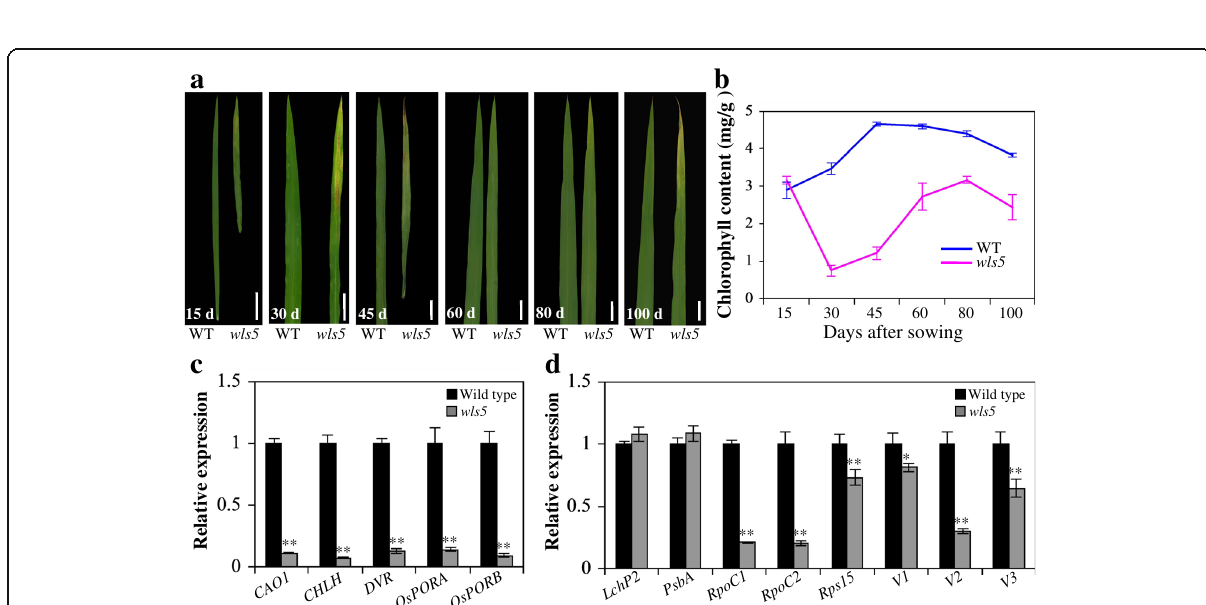
Fig. 4 Comparison of leaf senescence over time between wild-type (WT) and wls5 plants. a Leaf phenotype of WT ( ‘ 93 – 11 ’ ) and wls5 plants at different stages (The youngest fully expanded leaf). Bars = 2 cm. b Chlorophyll content of leaves in wild-type and wls5 plants. Error bars indicate SD, n = 10. c , d Expression of chlorophyll synthesis ( c ) and chloroplast development ( d ) related genes in WT and wls5 plants at tillering stage. Error bars indicate SD, n = 3. ** P < 0.01 (Student ’ s t